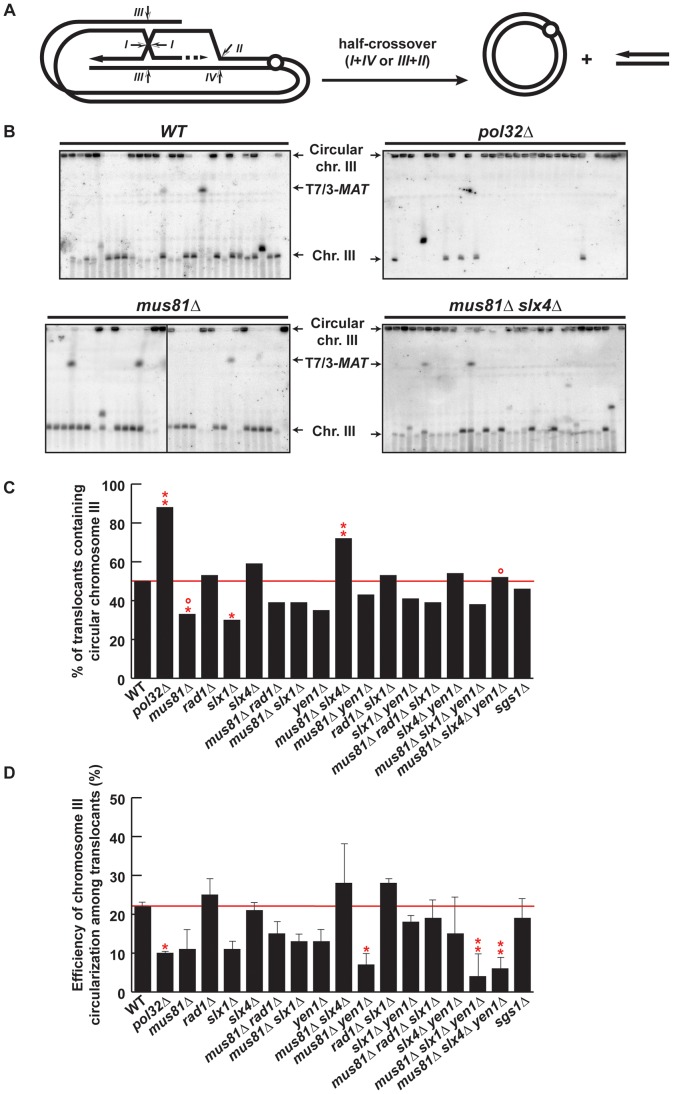
PFGE analysis of chromosome III circularization in SSE mutants.(A) Schematic representation of circularization of chromosome III by BIR plus half-crossover. Arrows indicate different ways of intermediate cleavage. (B) PFGE followed by Southern analysis using the 3R2 probe (See Figure 1G) of Ura− 5-FOAr survivors in WT, pol32Δ, mus81Δ, slx4Δ, mus81Δ slx4Δ and mus81Δ slx4Δ yen1Δ strains. Black arrows indicate the positions of T7/3-MAT translocations, and the circular and linear chromosomes III (Chr. III). PFGE, pulse-field gel electrophoresis. (C) Graphical plotting of percent of translocants containing circular chromosome III for each strain tested. (D) Frequency of chromosome III circularization among translocants. ** and *, differences with the WT statistically significant (p<0.01 and p<0.05, respectively, χ2 with Yates' correction) °, differences with mus81Δ slx4Δ statistically significant (p<0.01, χ2 with Yates' correction). Error bars represent standard deviations. See Table S1 for complete statistical analysis.